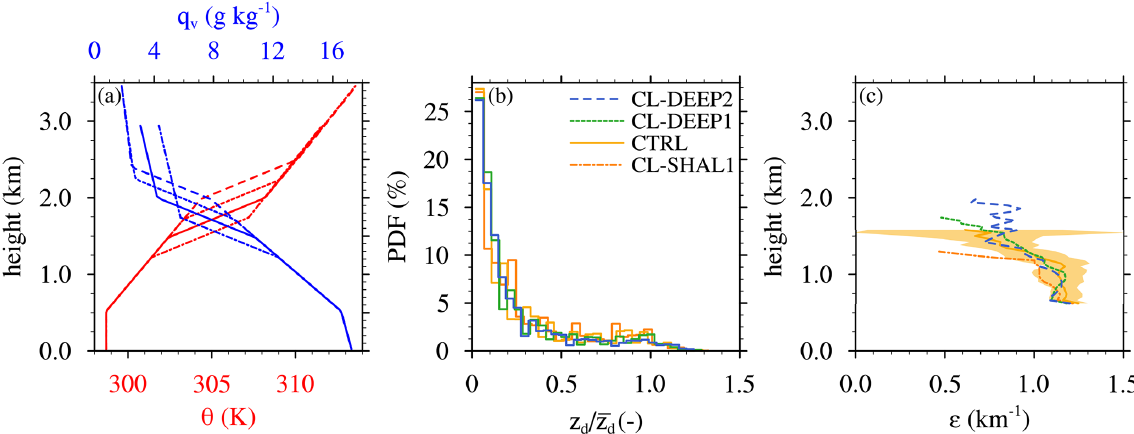
Figure 6. (a) Initial profiles of potential temperature ( θ ) and water vapor mixing ratio ( q v ) for the experiments with different cloud-layer depths. (b) The probability density function (PDF) of individual cloud-top heights as a fraction of the cloud-layer top and (c) the fractional- dilution-rate profiles for the cloud-layer-depth